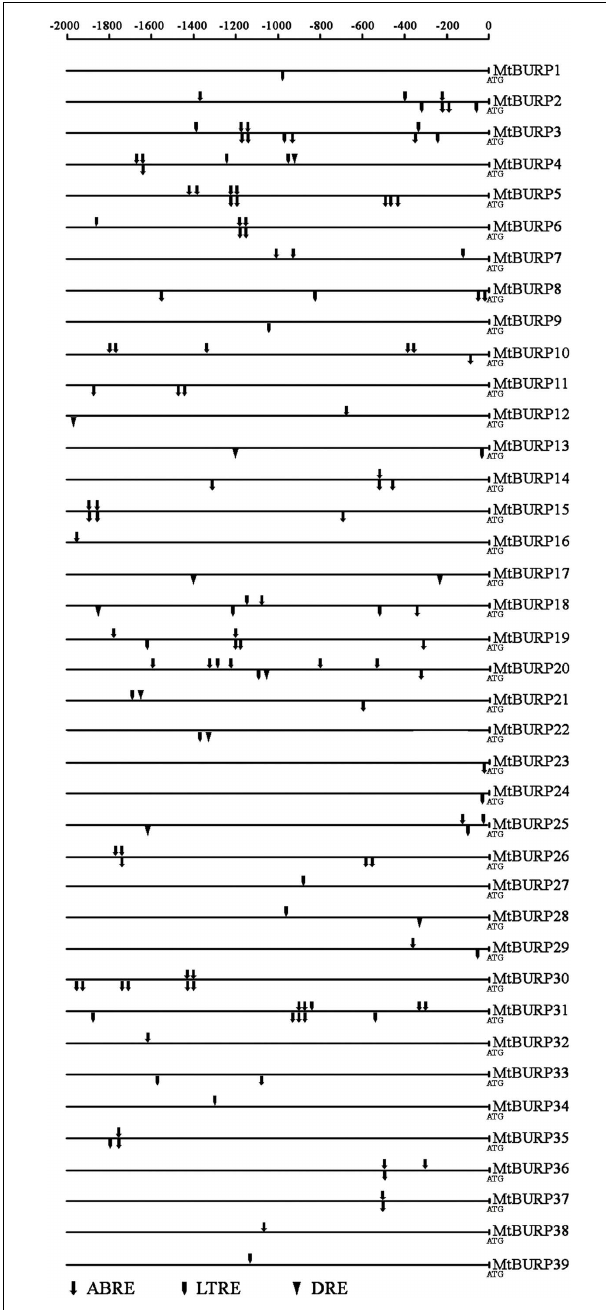
FIGURE 7 | Distribution of major stress-related cis -elements in the promoter sequences of MtBURP genes. Putative ABRE, LTRE and DRE core sequences are represented by different symbols as indicated. The cis -elements distributed on the sense strand and reverse strand are indicated above and below the black lines, respectively.